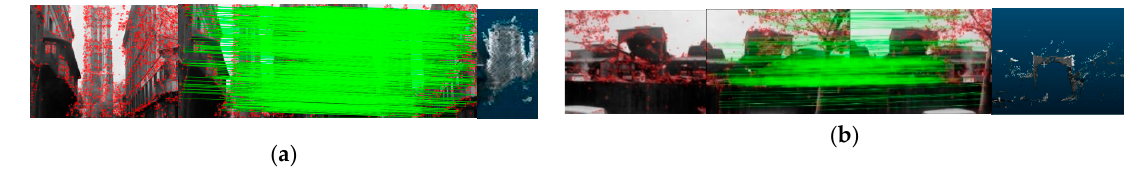
Figure 25. Results from Structure-from-Motion (SfM) pipeline: ( a ) reconstruction of the Tour Saint Jacques; ( b ) reconstruction of the Halles.